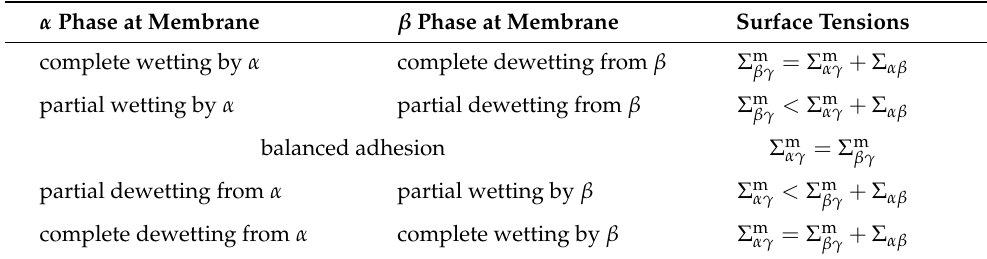
Table 2. Relationships between the three surface tensions for the different wetting regimes displayed in Figure 9. The first column describes the wetting behavior of the α phase, the second column the wetting behavior of the β phase, and the last column the corresponding relation between the surface